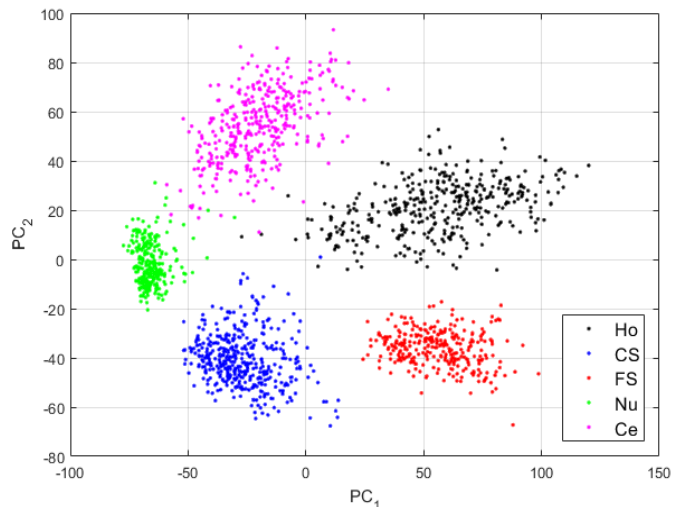
Figure 10. Visualization of the features learned by the DCAE in case-3. “Ho”, “CS”, “FS”, “Nu”, and “Ce” represent homogeneous, coarse speckled, fine speckled, nucleolar, and centromere cells, respectively. The percentages of the variance explained are, respectively, 56.86% and 33.61% for the first and second principal components.